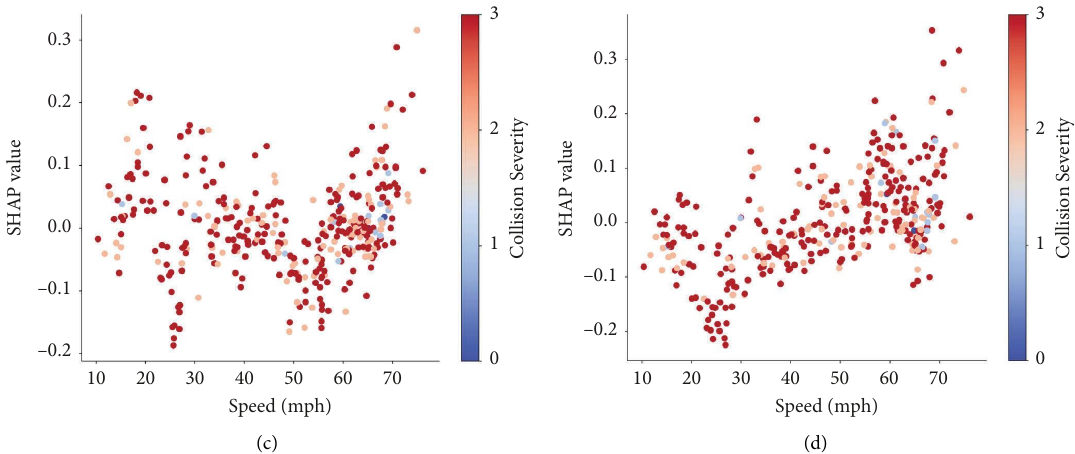
Figure 9: SHAP local dependence plots of collision severity. (a) Main efects of collision severity on the time gap. (b) Main efects of collision severity on the distance gap. (c) Interaction efects between collision severity and speed on the time gap. (d) Interaction efects between collision severity and speed on the distance